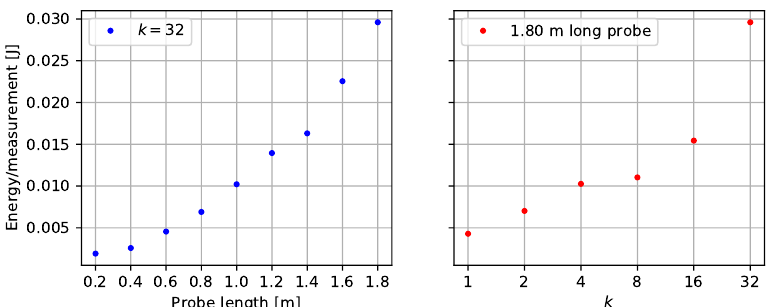
Figure 7. Energy per measurement as a function of probe length or the number of averaged measure- ments ( k